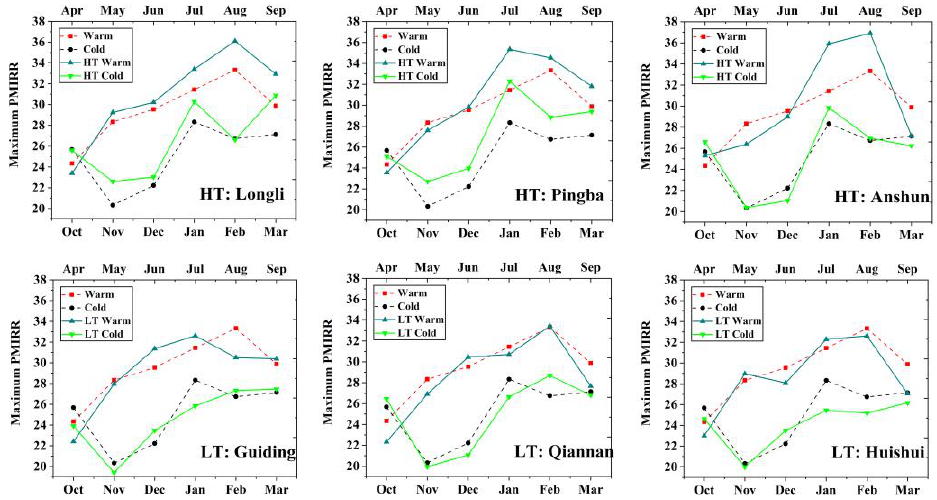
Figure 5. Change trends of water vapor in typical towns at different altitudes. The solid line for high town (HT)/low town (LT) is a typical town, and the dotted line represents the average of urban region.